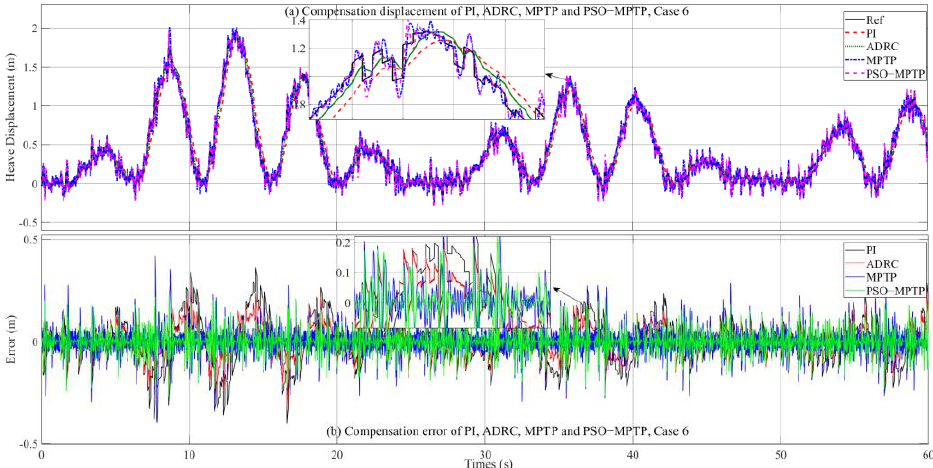
Figure 15. ( a ) Compensation displacement of PI, ADRC, MPTP, and PSO − MPTP, Case 6. ( b ) Com- pensation error of PI, ADRC, MPTP, and PSO − MPTP, Case 6.